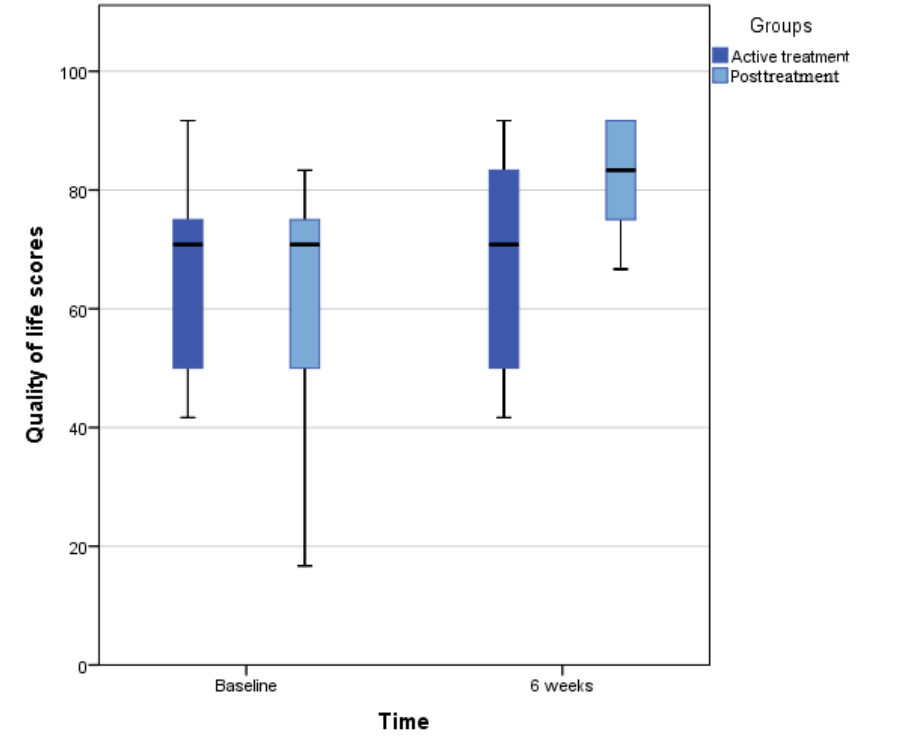
Figure 1. Boxplot of difference in baseline and 6-week global quality of life scores.